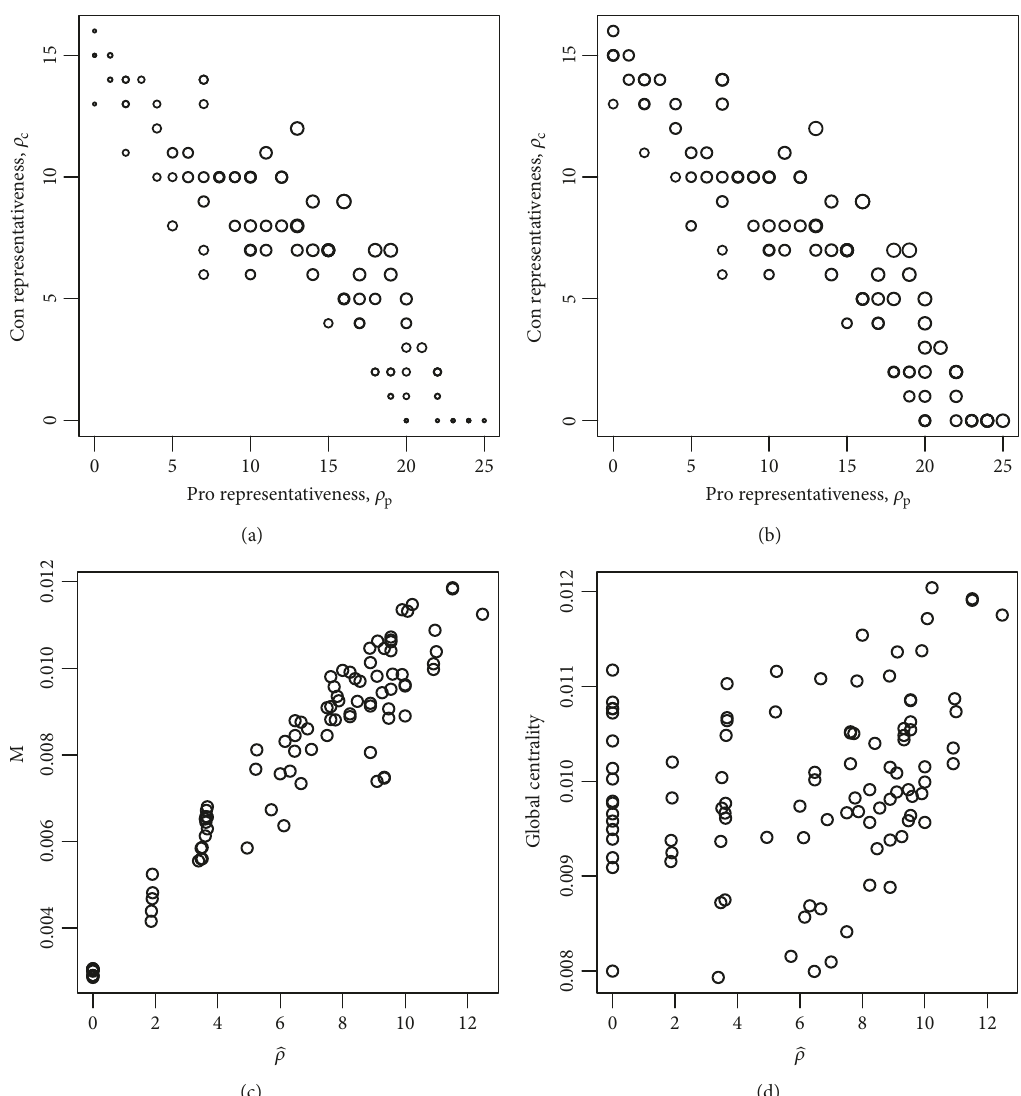
Figure 4: Comparison of mediation representativeness against mediation centrality and global centrality in Simulation 1. Each individual is represented by a dot. (a) Representativeness for pro and con reasons. Dot size represents mediation centrality. (b) Representativeness for pro and conreasons. Dot size representsglobalcentrality.(c)Global representativenessagainst mediation centrality.(d) Global representativeness against global centrality.